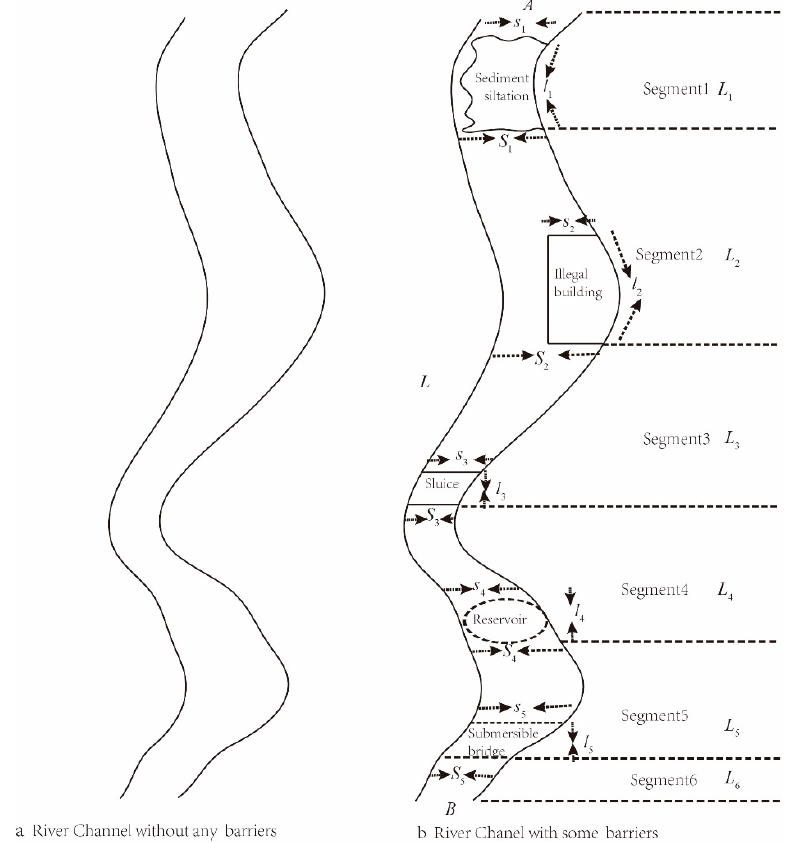
Figure 4. Conceptualized diagram of different barriers and parameters in the RCCI model. ( a ) is a natural river channel with no barriers; and ( b ) is the same river channel with some barriers.